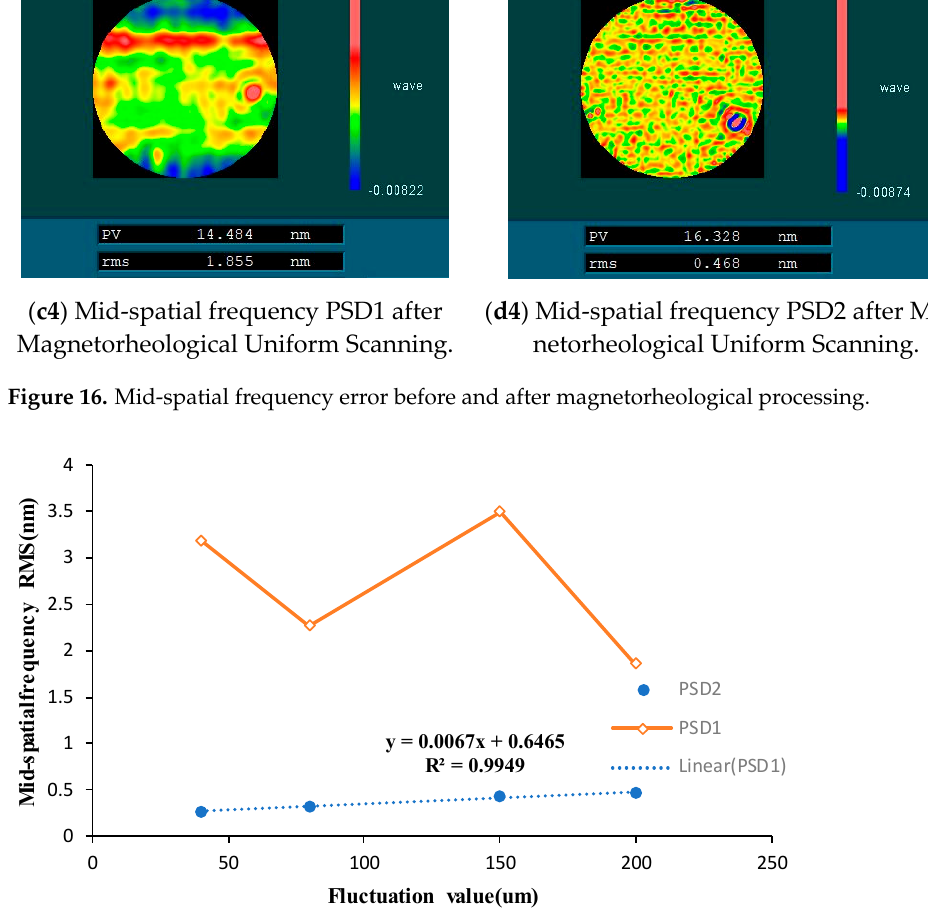
Figure 17. Effects of different ribbon fluctuations on mid-spatial frequency PSD1 and PSD2.